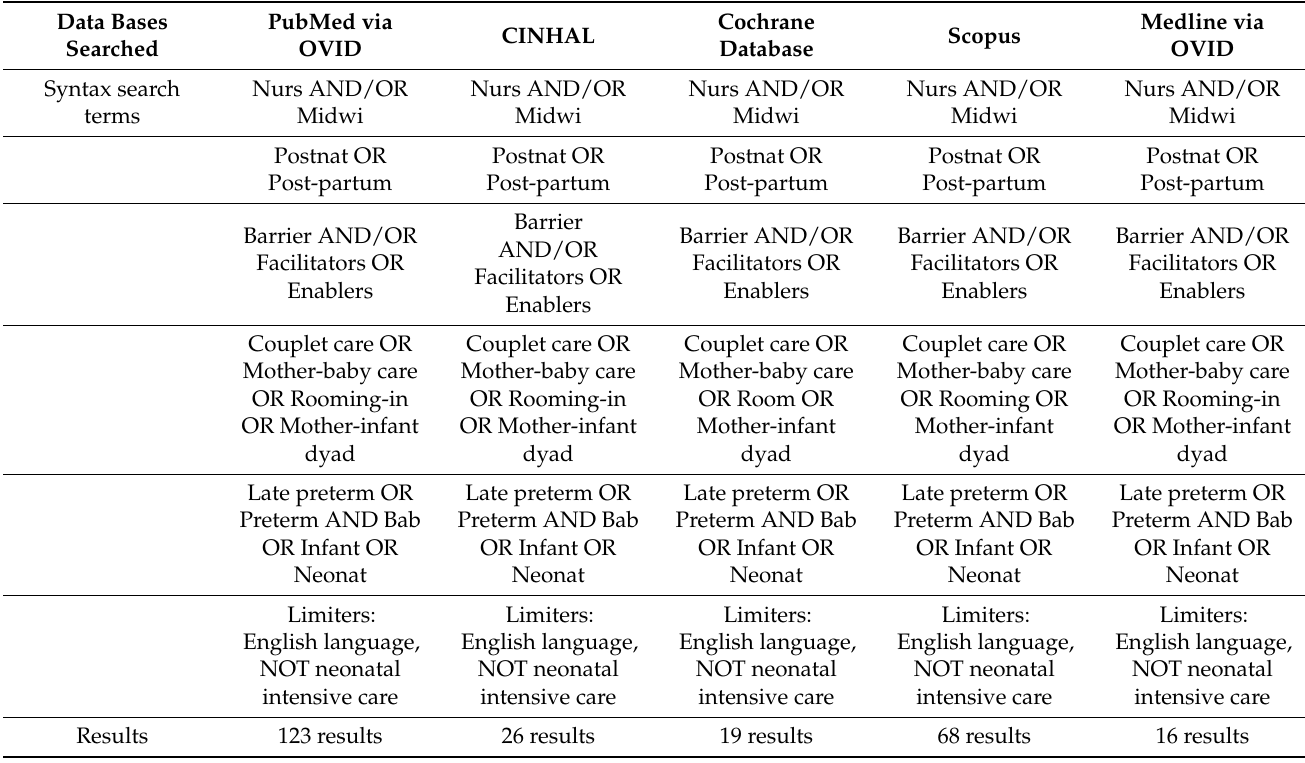
Table 2. Database syntax search